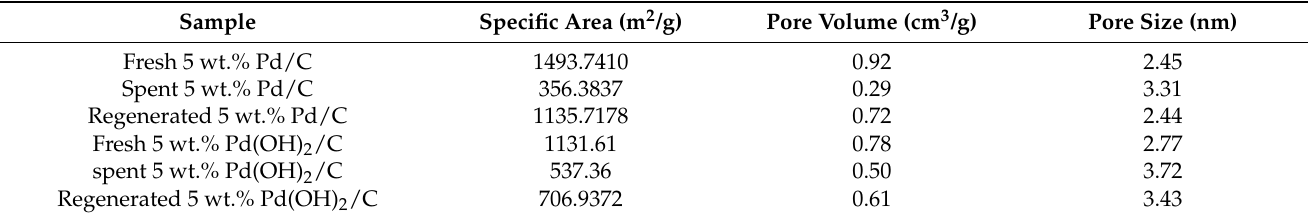
Figure 6. Nitrogen adsorption − desorption isotherms of fresh, spent and regenerated 5 wt.% Pd/C and 5 wt.% Pd(OH) 2 /C catalyst. Table 4. Textural and structural properties of fresh, spent and regenerated 5 wt.% Pd/C and 5 wt.% Pd(OH) 2 /C